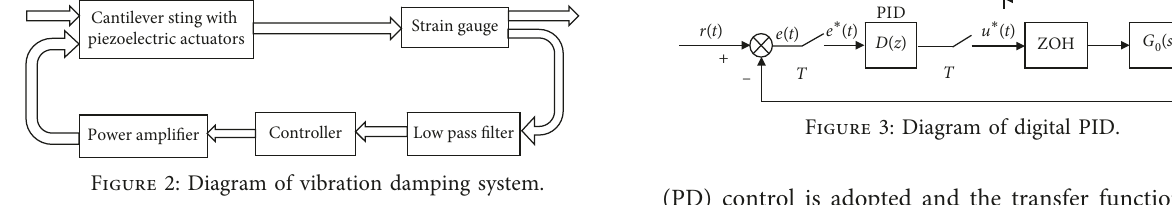
Figure 2: Diagram of vibration damping system.